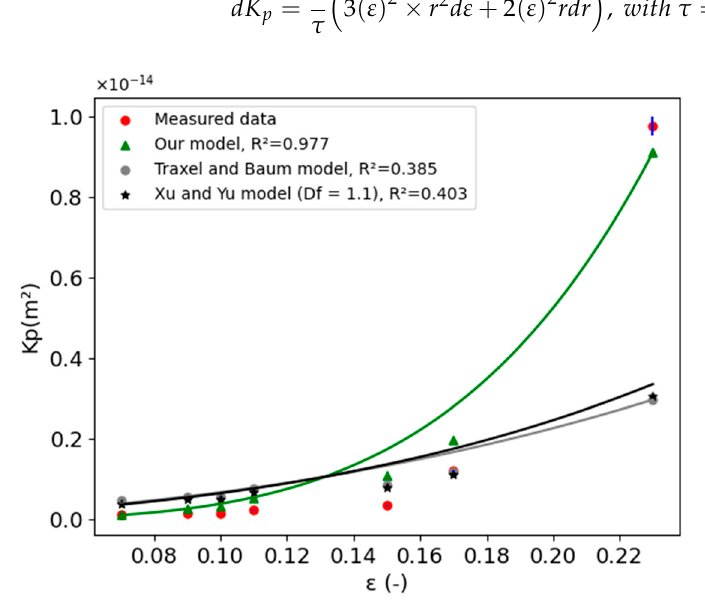
Figure 10. Variation of the permeability with the compressed MCC PH101 powder tablet porosity.